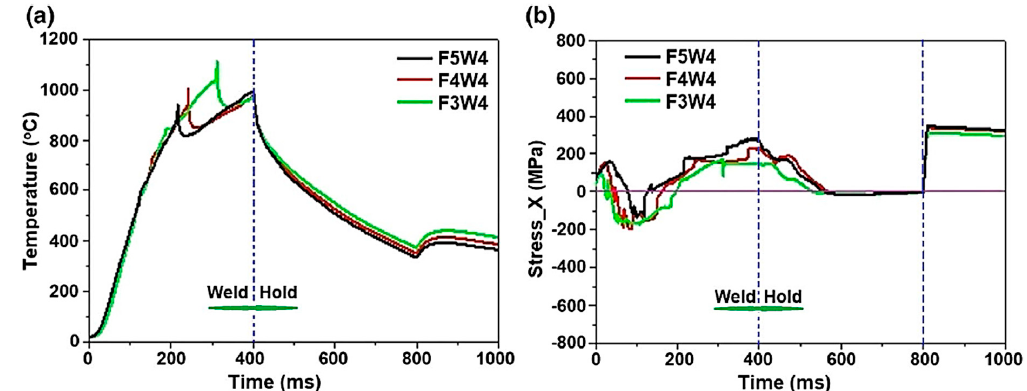
Figure 11. A comparison of ( a ) temperature profile and ( b ) stress history across various welding conditions at node 583 location. Reprinted with permission from [36], Springer, 2018.